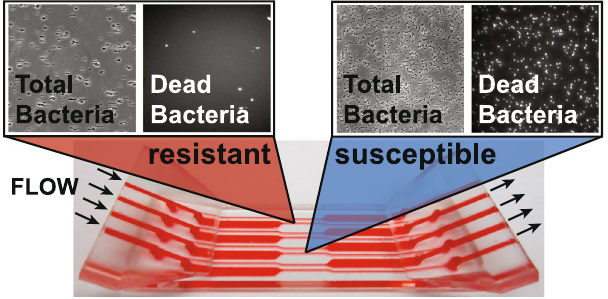
Figure 1. Stress-based antibiotic susceptibility testing method. Shear flow potentiates the action of antibiotics against bacteria covalently-bound to the floor of a microfluidic channel. Bacterial death is monitored over time via automated microscopy. A fluorescent dye gives the number of dead bacteria while phase contrast images show the total bacterial count. If the percent of dead bacteria is > 6% at the end of the assay, the strain is susceptible to the antibiotic of